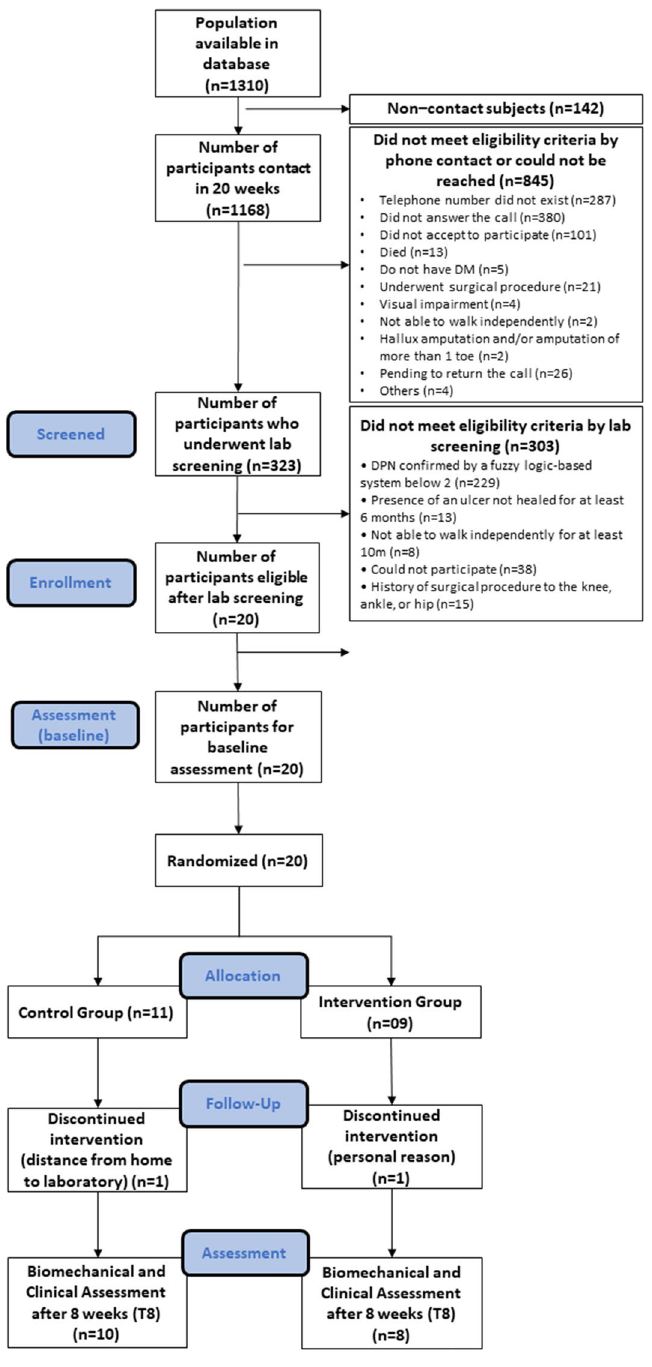
Figure 1. Flow chart of the feasibility study explaining reasons for inclusion and exclusion. T8 evaluation at 8 weeks, DM diabetes mellitus, DPN diabetic peripheral